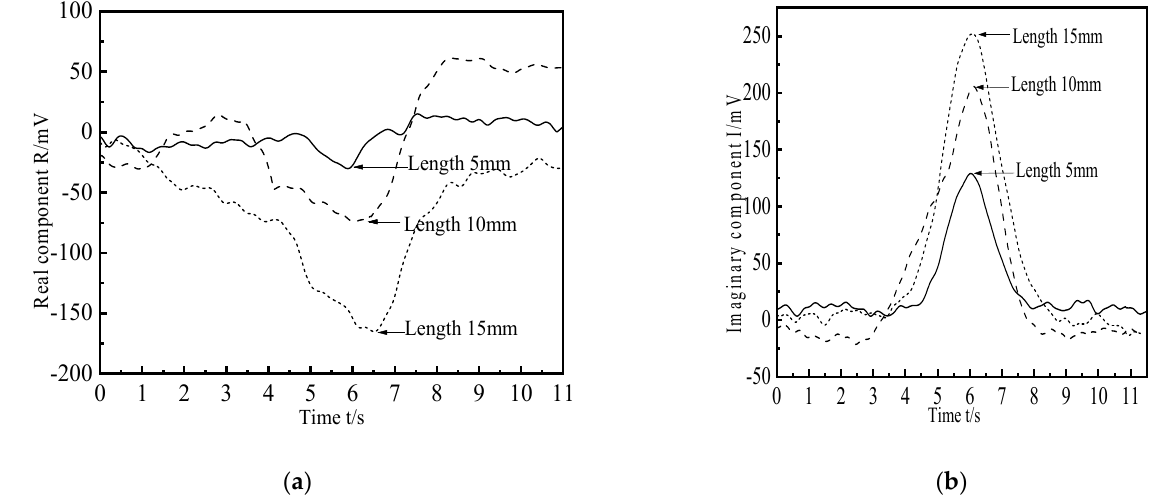
Figure 21. Real and imaginary components of crack-like defect detection signals with different lengths. ( a ) Real component; ( b ) Imaginary component.